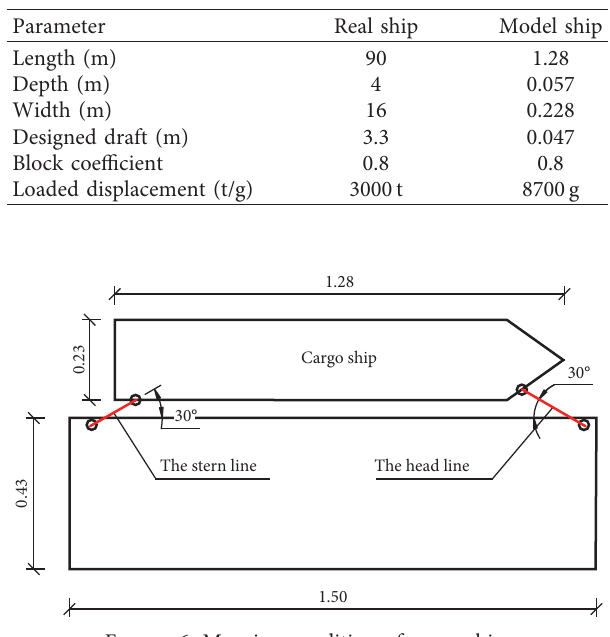
Table 3: Primary parameters of the real and model ship.